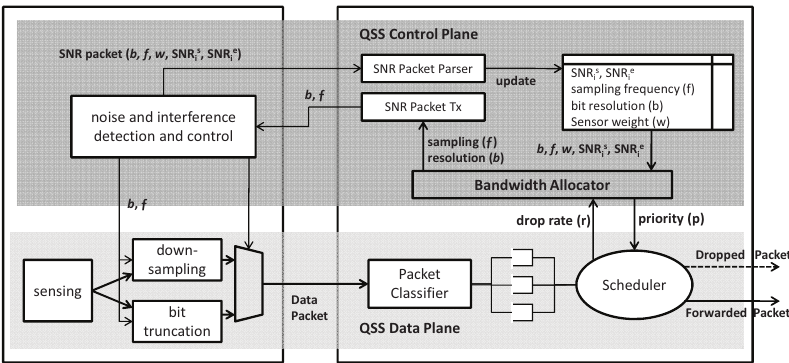
Figure 5. Quality-aware scheduling system (QSS)